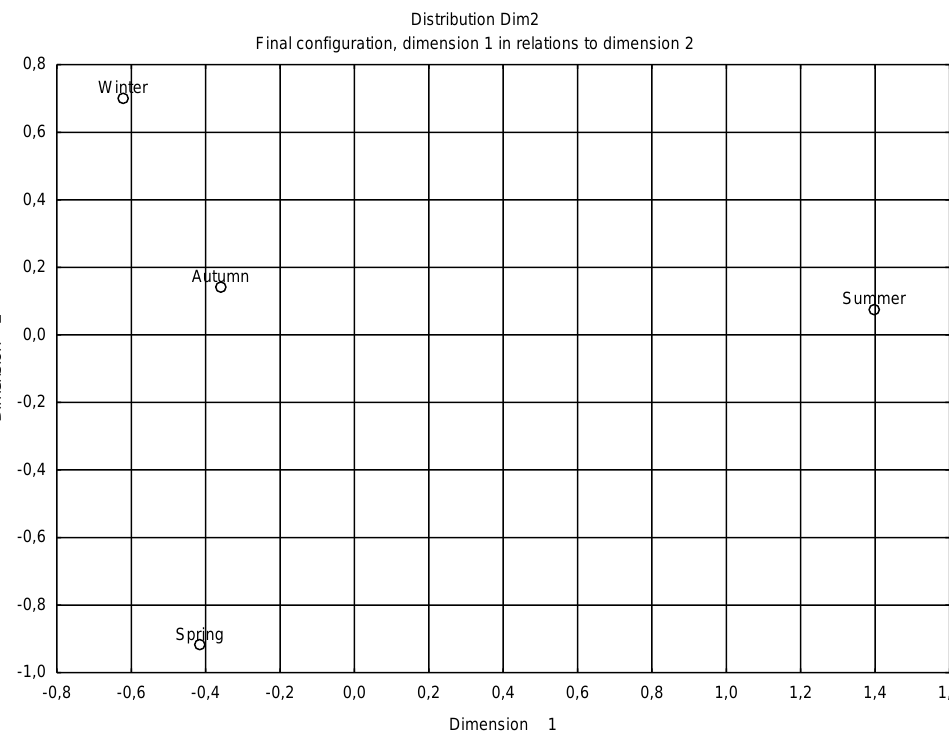
Figure 7. Multidimensional scaling results for individual objects (seasons) including all characteristics (tap water param- eters). Table 5. Results of regression analysis between tap water parameters and the dimensions of exam- ined units.